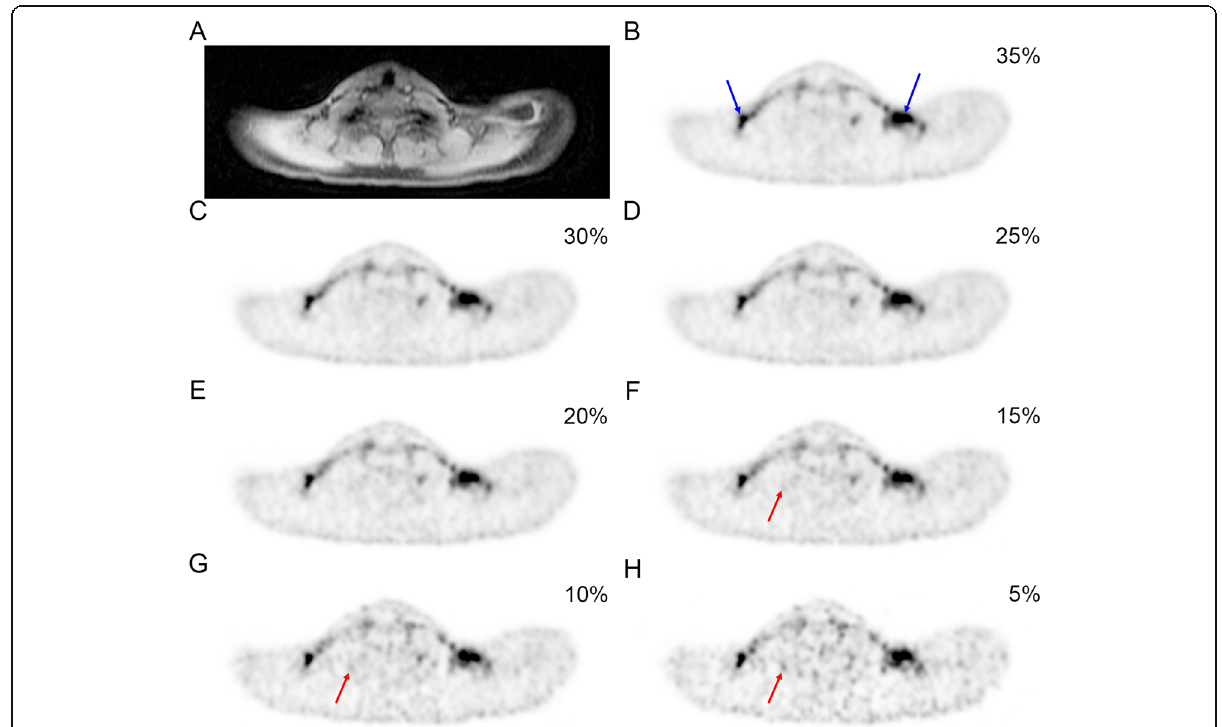
Fig. 1 Representative dataset showing the supraclavicular BAT on MR and on PET reconstructed images with decreasing activity. a Axial MRI “ water ” image. b – h Axial TOF PET images reconstructed with 35%, 30%, 25%, 20%, 15%, 10%, and 5% of the original counts, thereby simulating corresponding lower doses. Blue arrows indicate supraclavicular BAT, and red arrows indicate increasing artifacts with decreasing